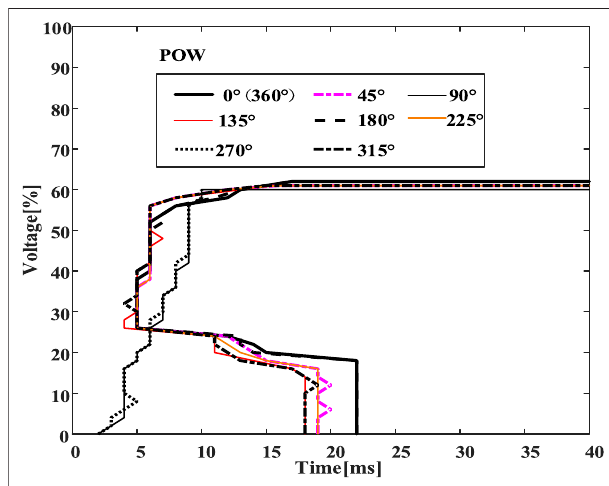
FIGURE 7 | Illustration of quarter-cycle symmetry (R1, 0 °